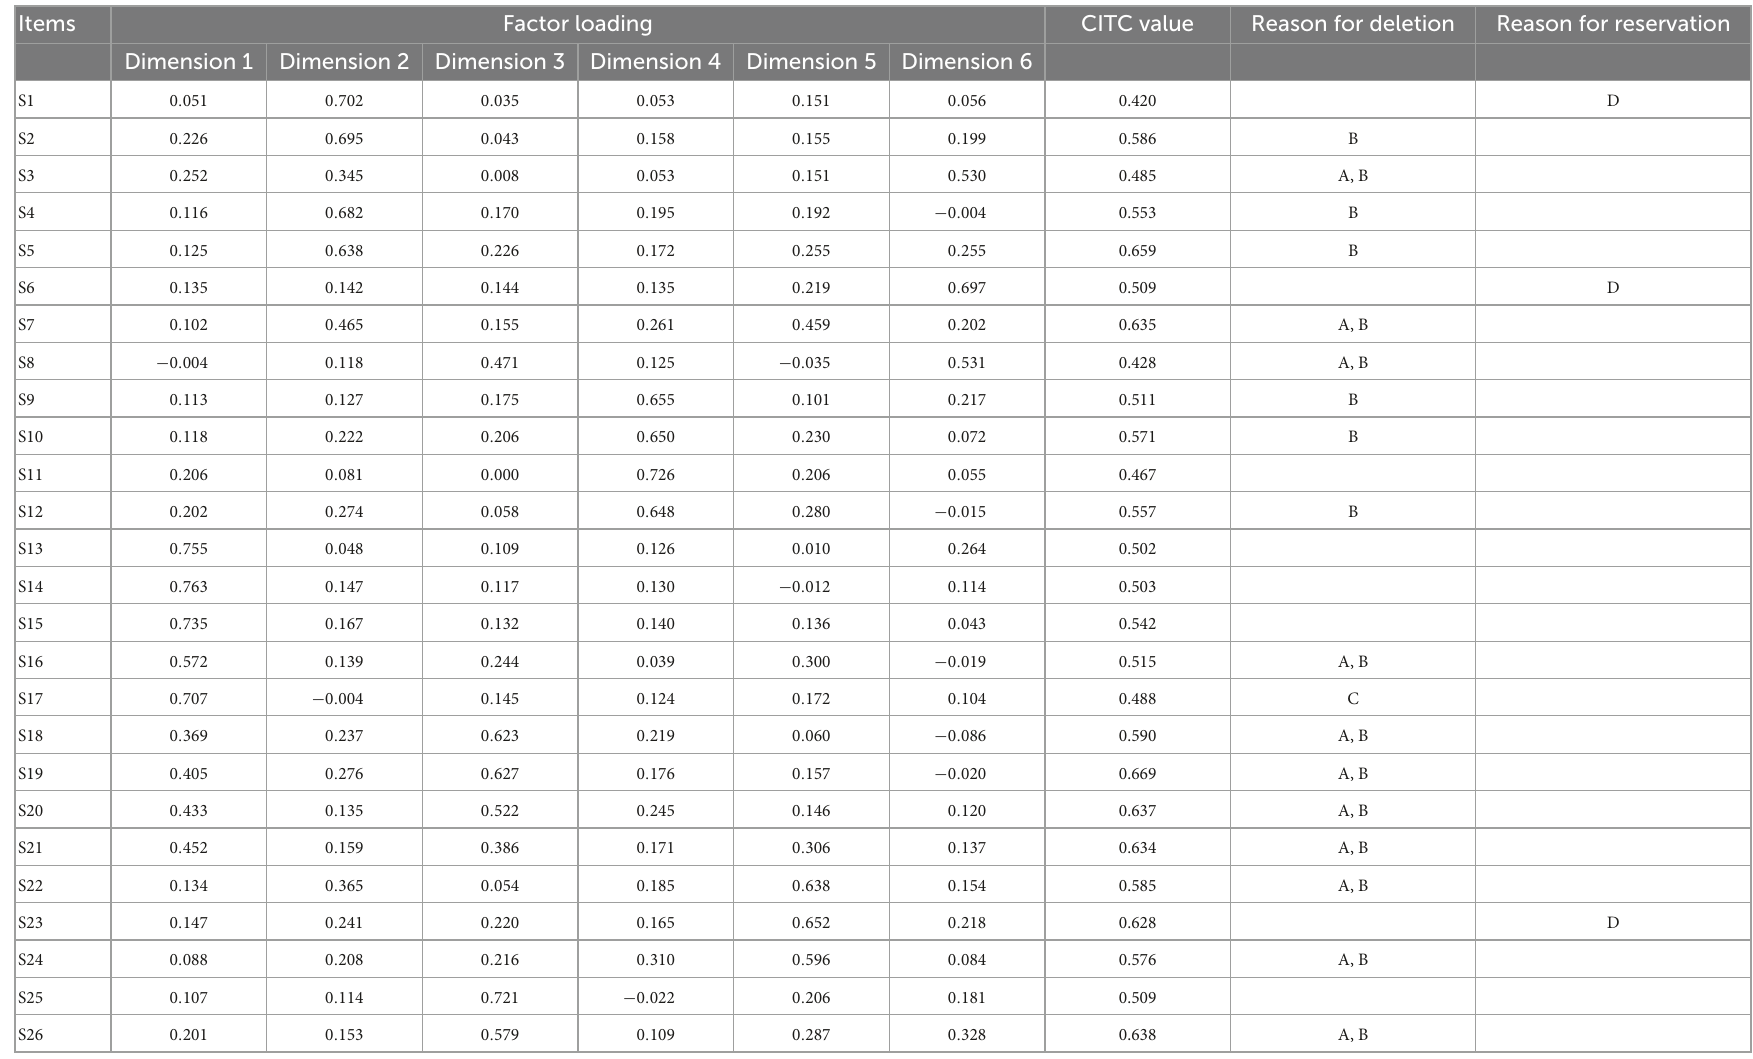
TABLE 3 Factor analysis of subsample I.